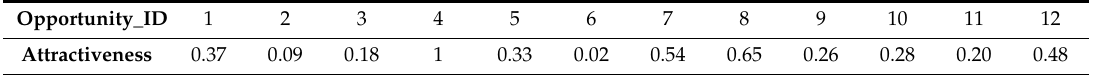
Table 4. Attractiveness of Kowsar markets (standardized values).